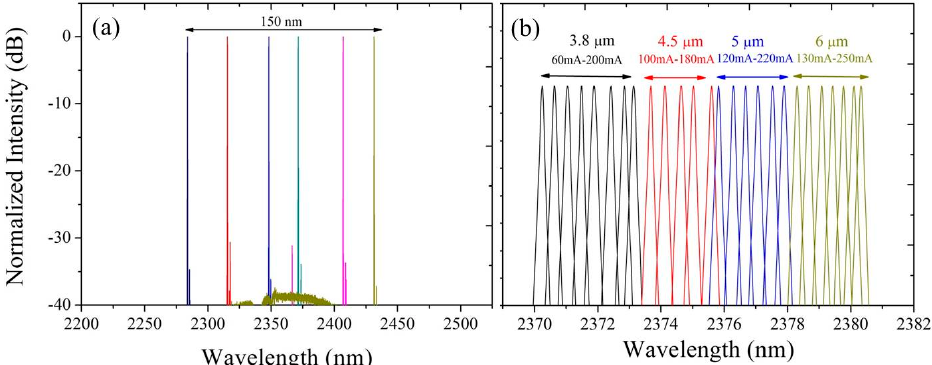
Figure 7. ( a ) Emission spectra of six 1000 μ m-long DFB lasers with different silicon grating period in an array; ( b ) evolution of the emission spectrum with bias current for four 700 μ m long DFB lasers with different III–V waveguide widths in an array.